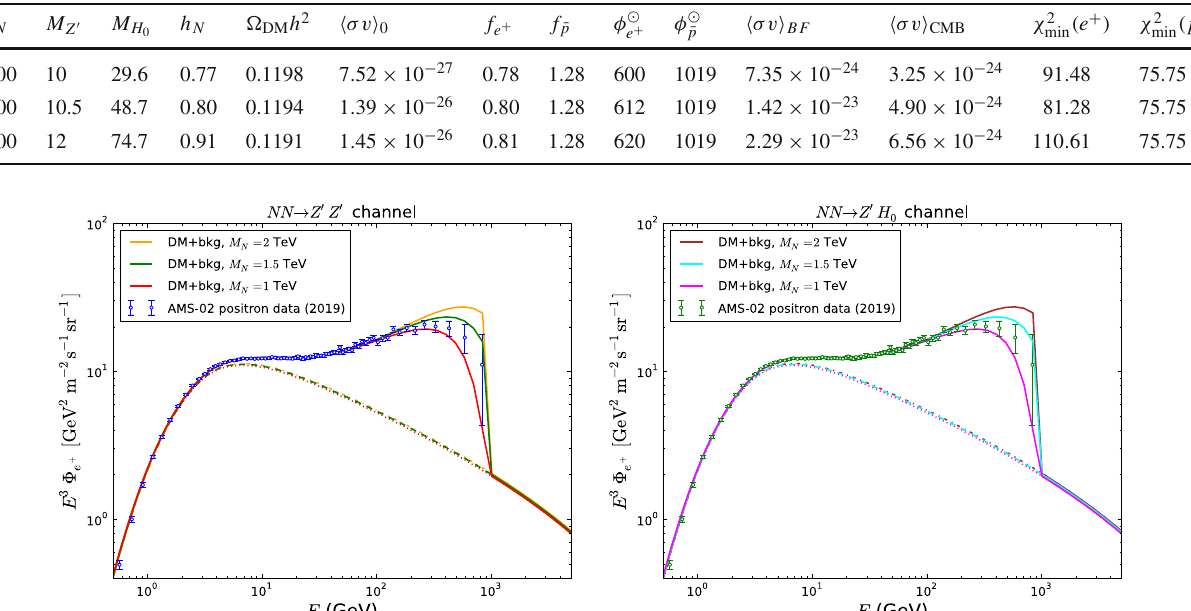
been chosen such that the resulted Sommerfeld enhancement factors are match to fitted boost factors, i.e., S E (cid:7) BF have 0